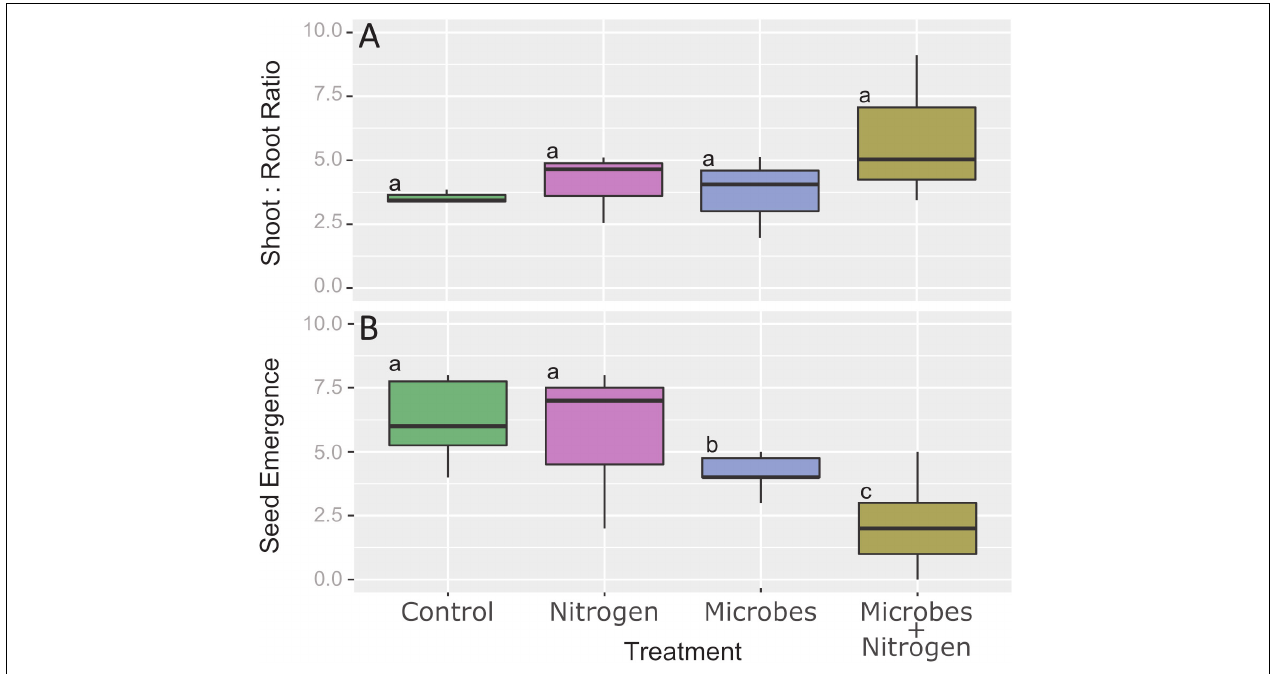
FIGURE 2 | Boxplot representing (A) shoot:root ratio and (B) seed emergence across all 4 treatments. Boxplot sharing same letter coding are significantly similar ( P ≤ 0.05).